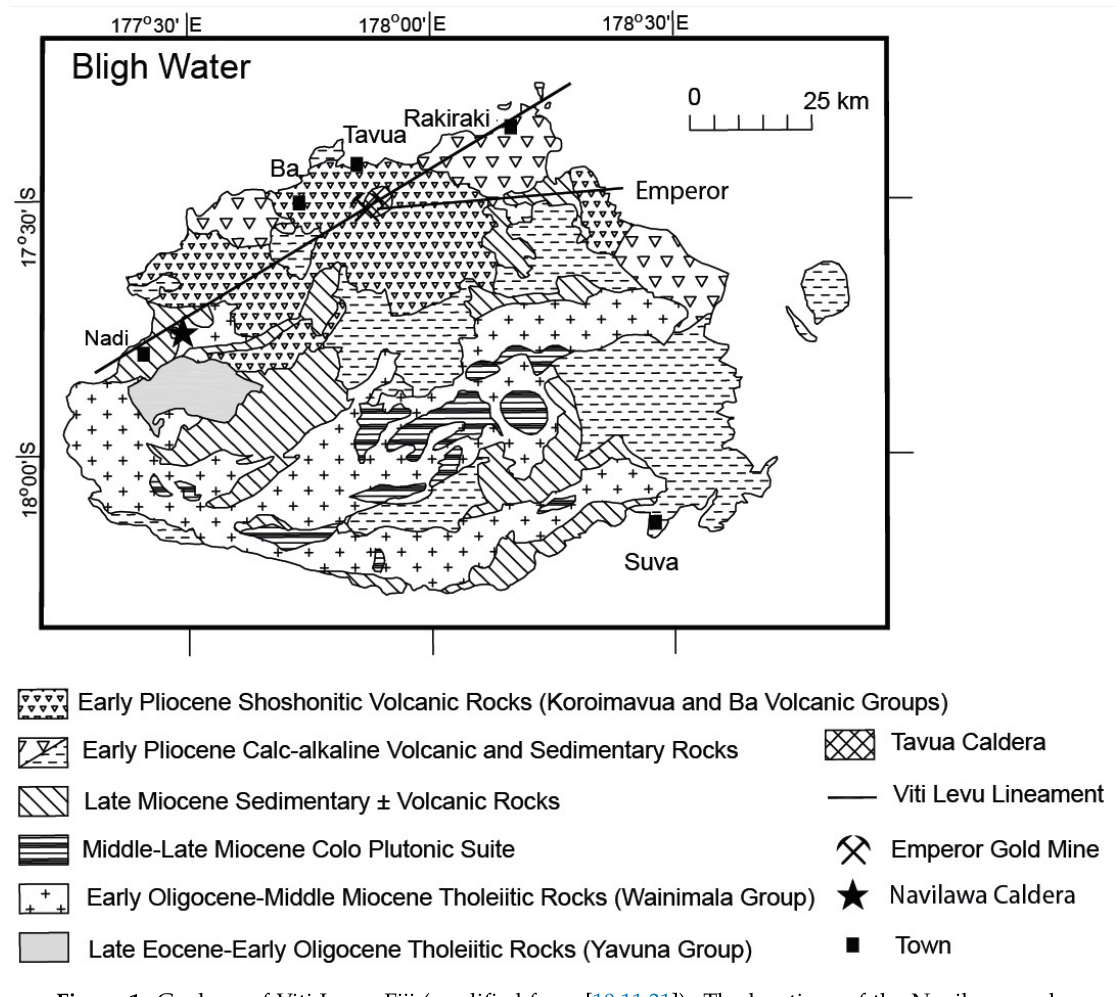
Figure 1. Geology of Viti Levu, Fiji (modified from [10,11,31]). The locations of the Navilawa and Tavua calderas relative to the Emperor deposit and the Viti Levu lineament are shown.